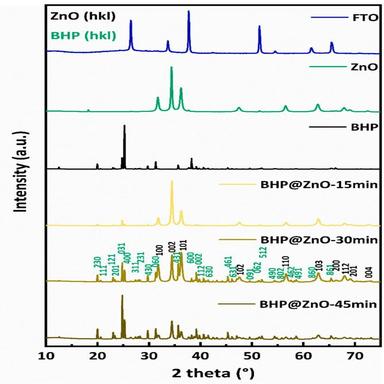
X-ray diffractograms of BHP deposited on ZnO at different current densities.